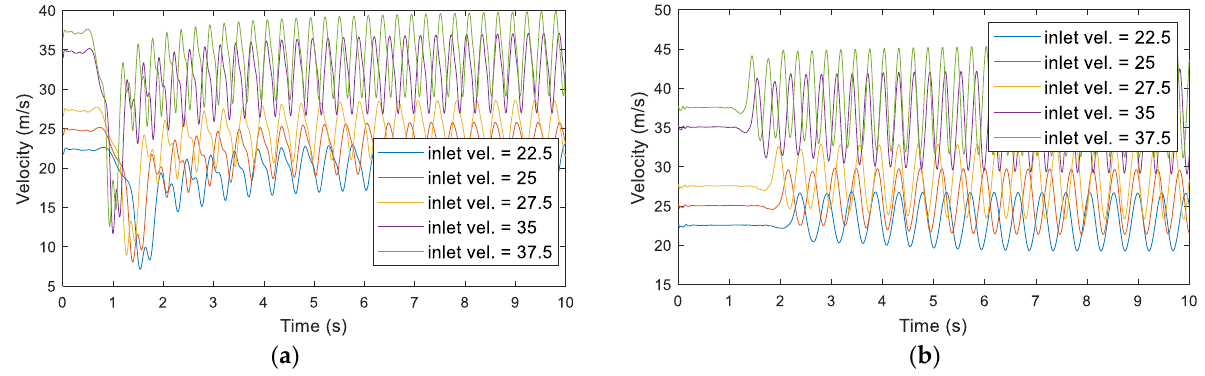
Figure 6. Example 1: x-direction velocity profiles for different inlet velocities: ( a ) Location (20.9761, 7.8896); ( b ) Location (39.3667, 11.3086).